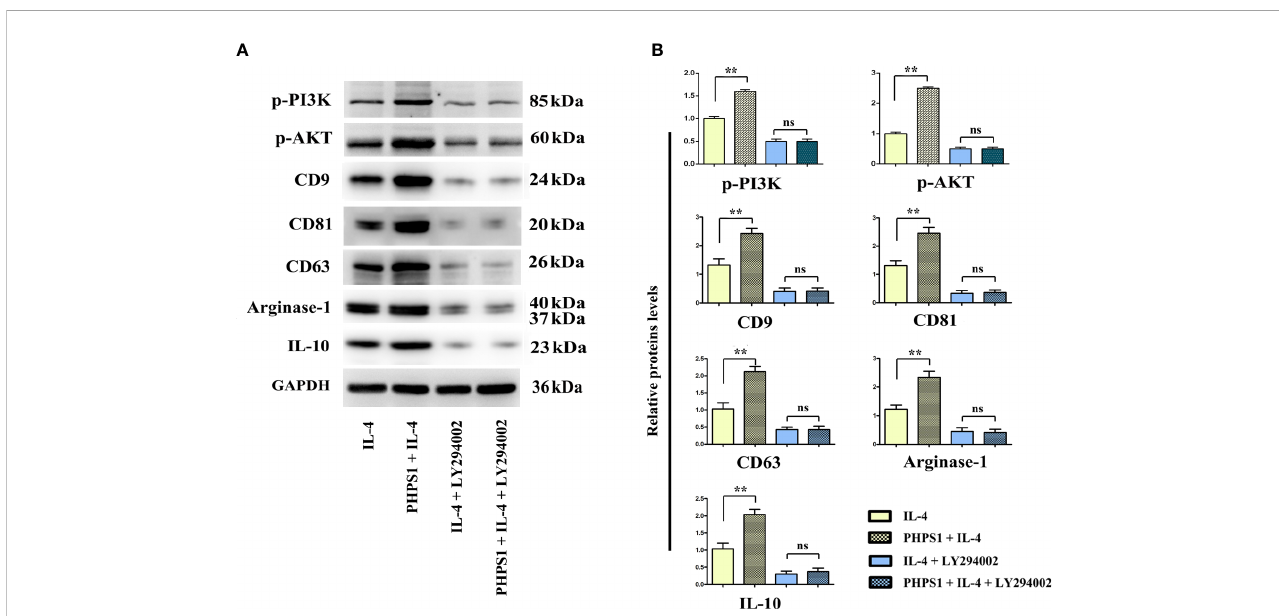
FIGURE 8 Low SHP-2 expression may facilitated the release of exosomes in M2 macrophages through PI3K/AKT signaling pathway. (A) Western bolt was used to detect the protein levels of p-PI3K, p-AKT, CD9, CD81, CD63, Arginase-1 and IL-10; (B) Quantitative analysis of the protein expression of p-PI3K, p-AKT, CD9, CD81, CD63, Arginase-1 and IL-10; ns indicated no statistical difference. All experiments were independently repeated three times. Src homology region 2 domain-containing protein tyrosine phosphatase-2; CRC, colorectal cancer. ns indicated no statistical difference; ** indicated P